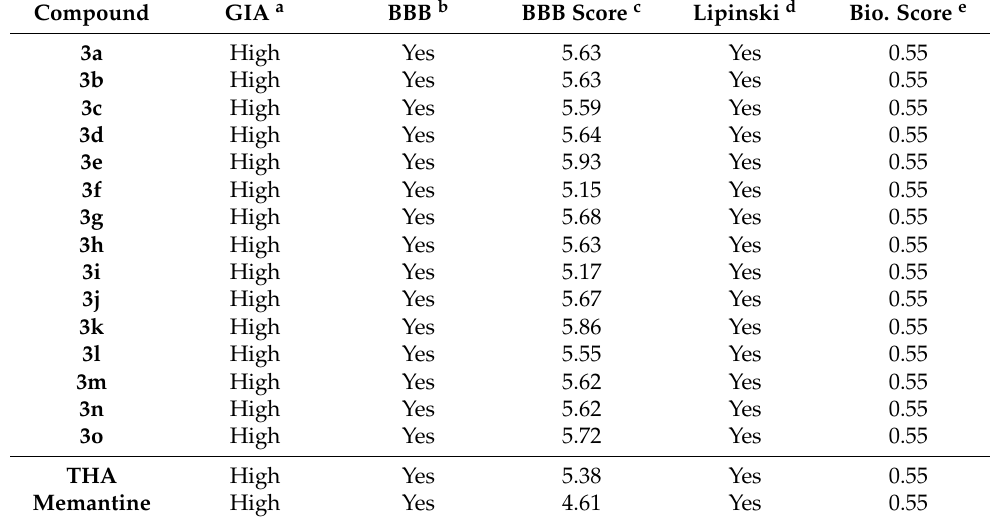
Table 1. Summary of the in silico absorption, distribution, metabolism, and excretion (ADME) and drug-likeness of derivatives 3a – o with tacrine (THA) and memantine using various prediction models. Compound GIA a BBB b BBB Score c